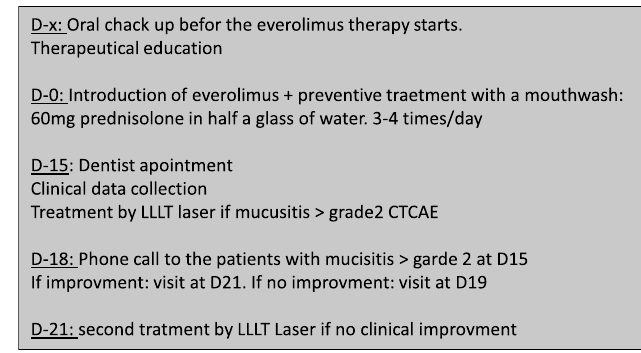
Fig. 6. Procedure for treating patients who are being treated with mTOR